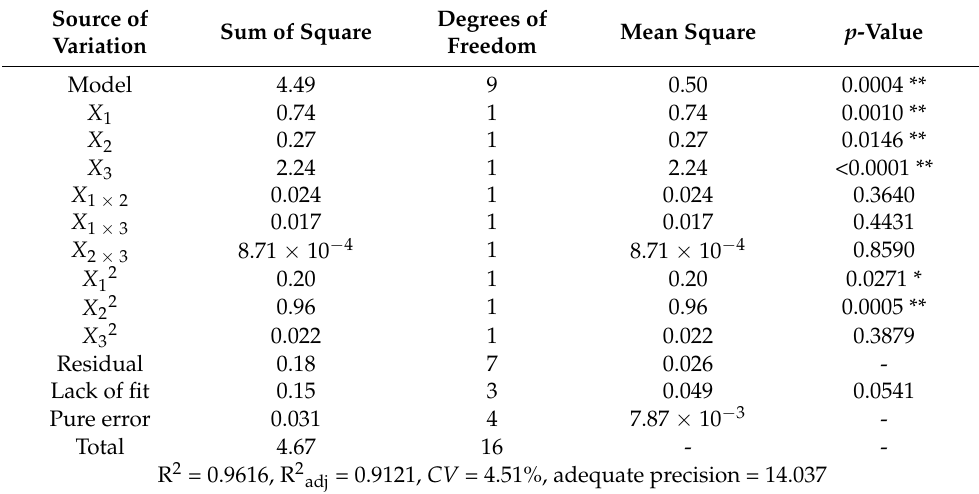
Degrees of Mean Square p -Value Freedom